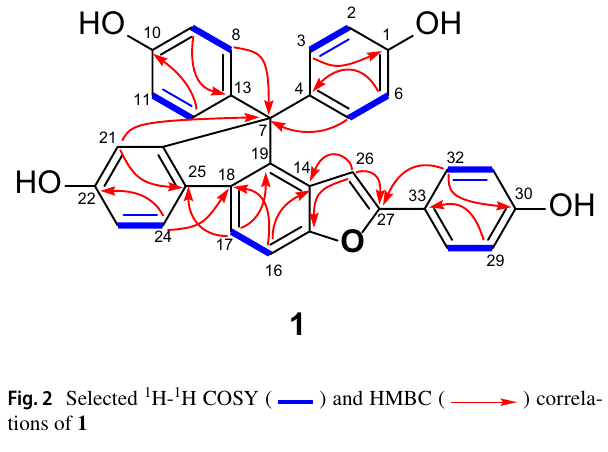
Fig. 2 Selected 1 H- 1 H COSY ( ) and HMBC ( ) correla- tions of